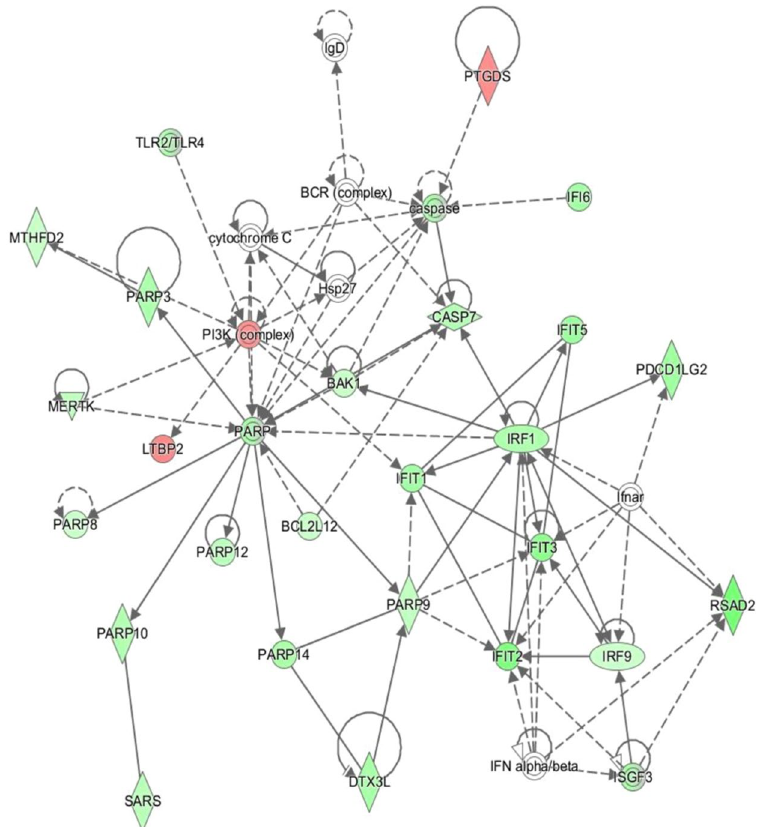
Figure 3. Infectious Diseases network enriched in comparison of Beef CL 48 h v Beef LF 48 h. Network 5- Infectious Diseases, Antimicrobial Response, Inflammatory Response network over enriched in comparison of beef CL 48 h and beef LF 48 h calves. The network is displayed graphically as nodes (genes). The node colour intensity indicates the expression of genes; with red representing up-regulation and green, down-regulation in 48 h beef CL calves compared to 48 h beef LF